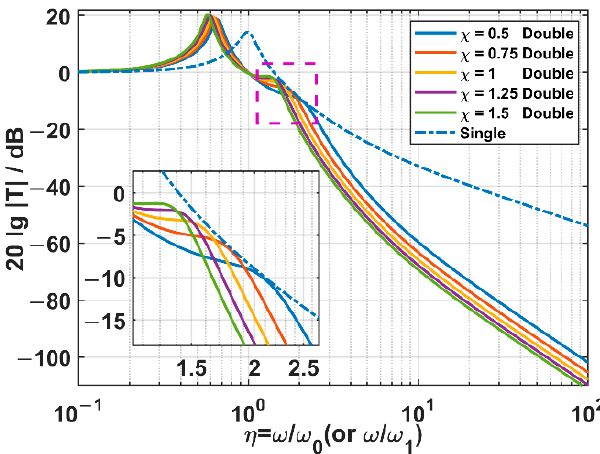
Figure 8. The acceleration transmissibility spectra of two suspension systems in different mass ratio cases. Among them, the dashed line is the result of the OSSS, while the solid lines are those of the TSSS.